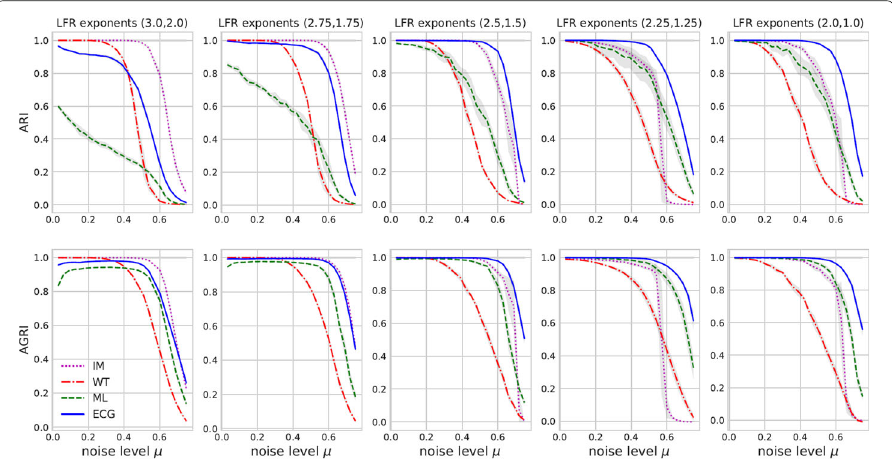
Fig. 7 We measure the quality of the communities found by the InfoMap (IM), WalkTrap (WT), Louvain (ML) and ECG algorithms over LFR graphs with 5 different choice of power law exponents. Comparison to ground-truth is done with the ARI (top) and AGRI (bottom) measures. The LFR exponents vary in each column, in the same order as in Fig. 6. On the leftmost column plots, we see that ML does not do very well, ECG does much better and IM yields the best results. Recall that those graphs have many small communities of similar sizes. As we look toward the plots on the right, ML does progressively better and ECG yields the best